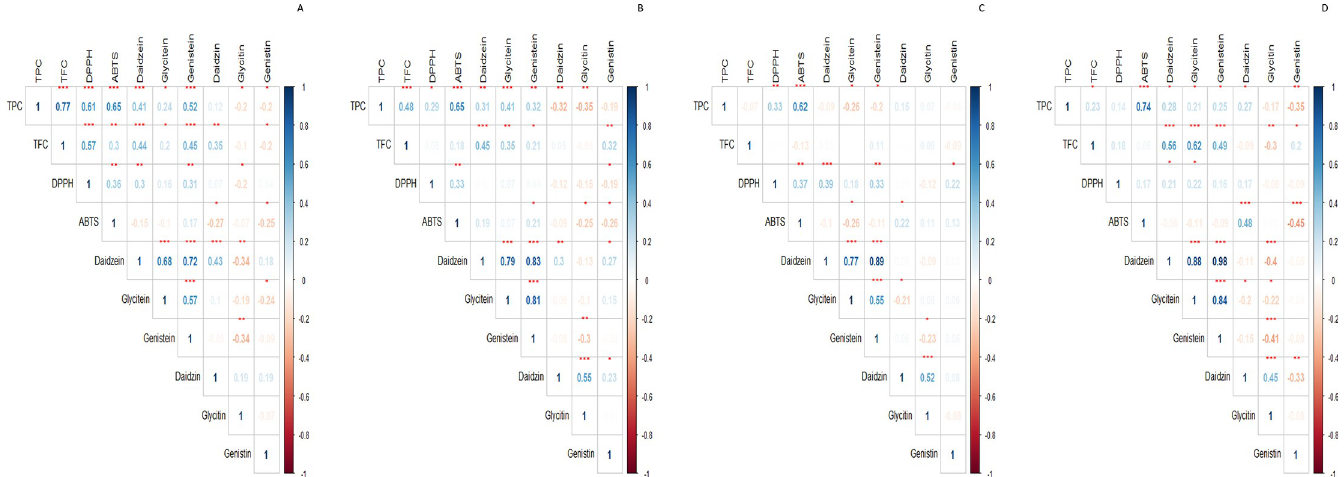
Fig 5. Correlations (R values) among isoflavones, TPC, TFC, and antioxidant capacity of small-seeded and large-seeded soybeans during germination under light and dark conditions. � p < 0.05; �� p < 0.01; ��� p < 0.001. A, small-seeded soybeans under light; B, large-seeded soybeans under light; C, small-seeded soybeans under dark; D, large-seeded soybeans under